Question: State the chart type depicted above.
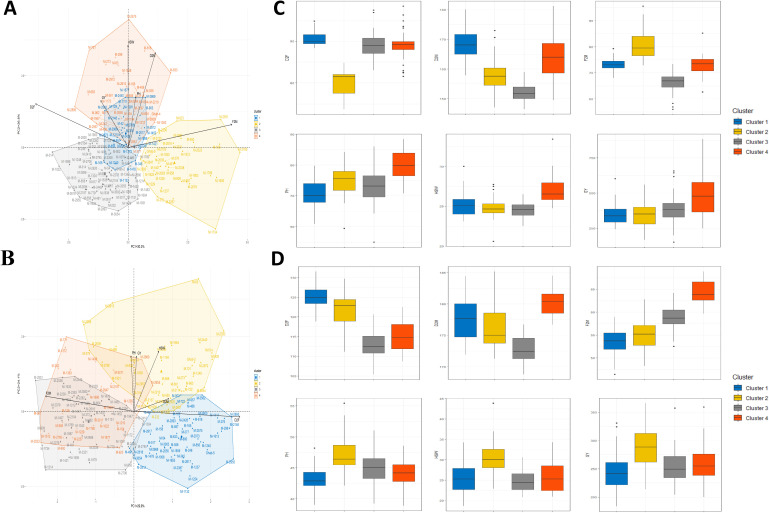
Answer: scatter